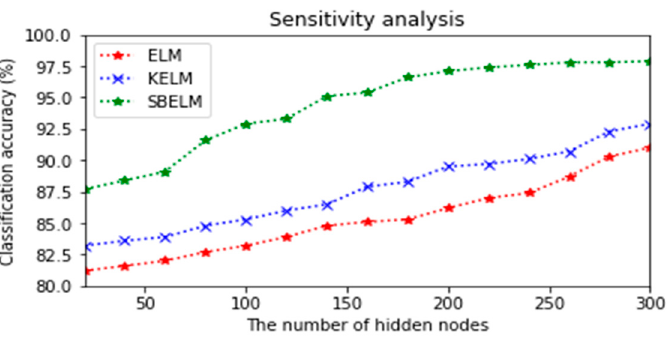
Figure 8. Sensitivity analysis.